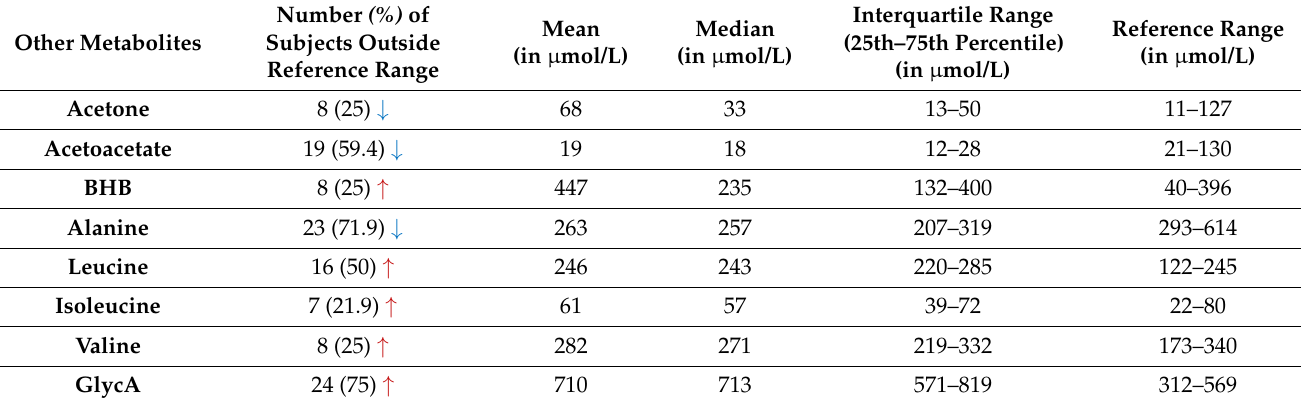
Table 4. Tabular summary of the levels of all other metabolites assayed in our study